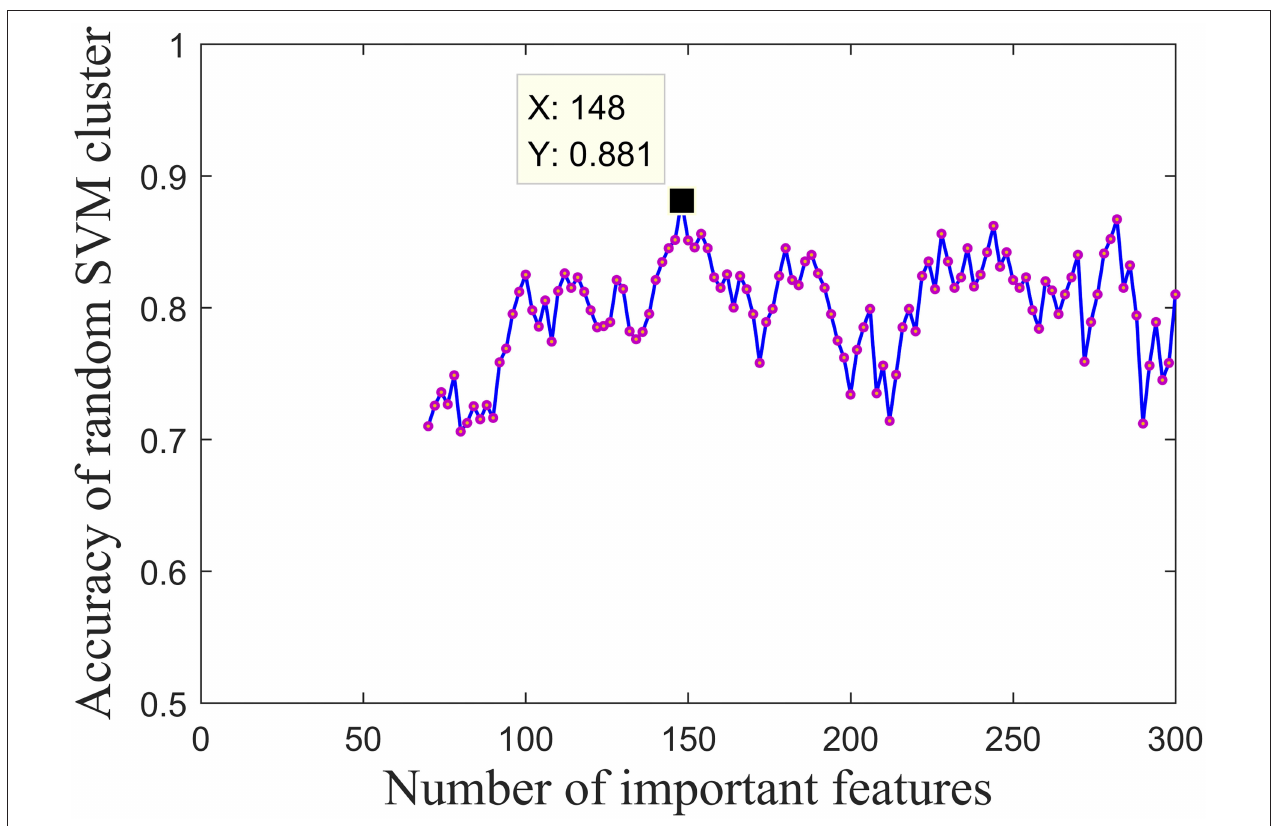
FIGURE 5 | Accuracies of the random SVM cluster with different numbers of important fusion features.